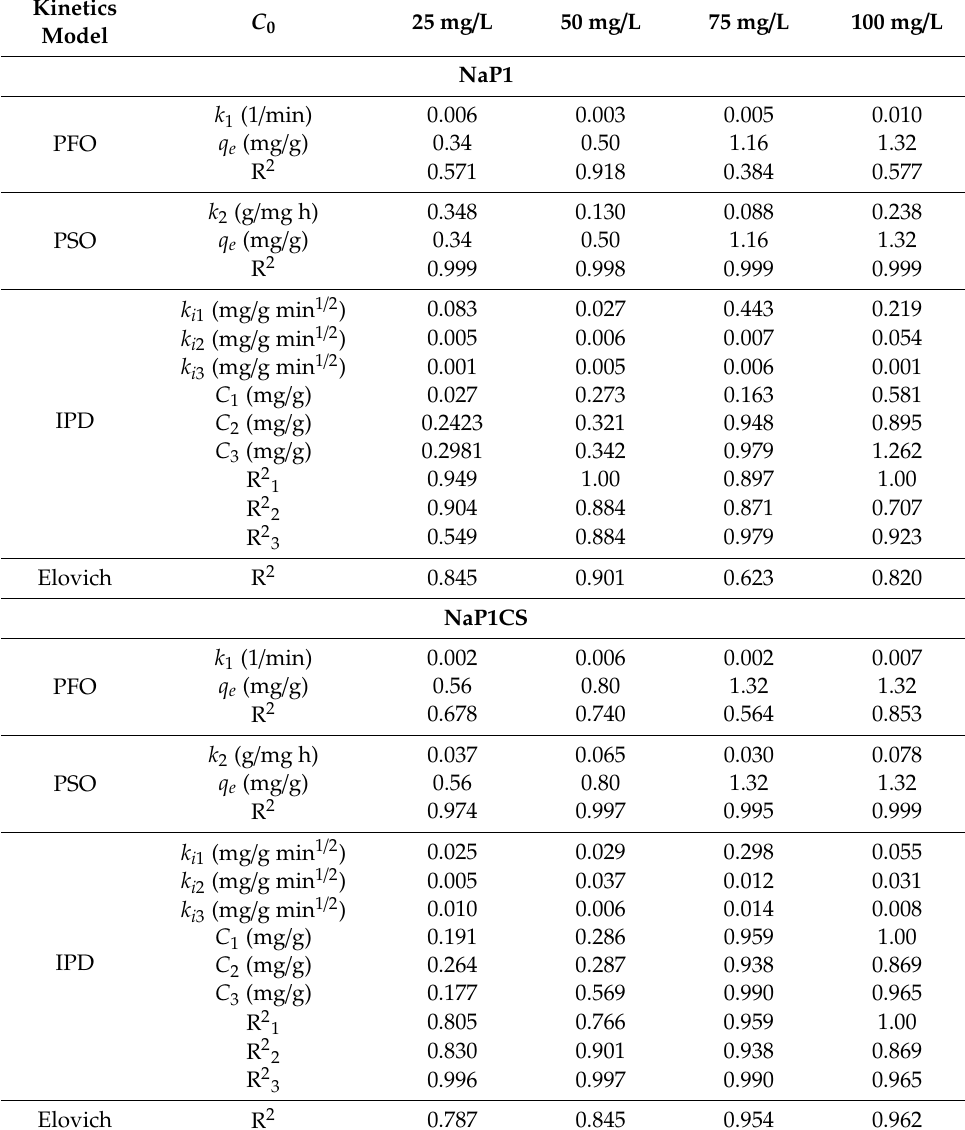
Table 6. Comparison of kinetic parameters for phenol on NaP1 and